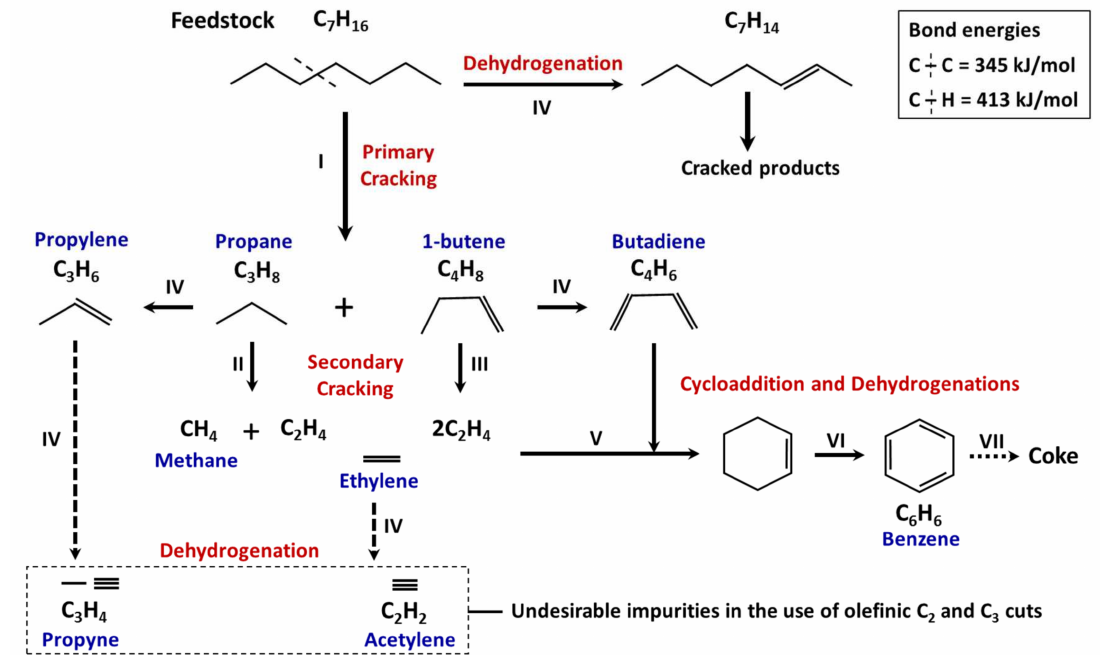
Figure 4. Main reactions involved in the cracking of higher alkanes, reproduced from